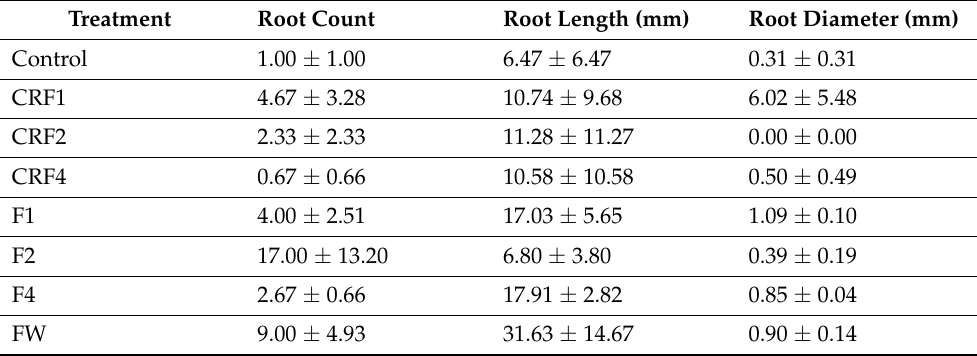
Table 5. Root growth parameters measured in March 2021 at a depth of 15.7–31.4 cm. A one-way analysis of variance (ANOVA) with a Tukey honestly significant difference (HSD) test was used to determine significant differences between means. Data represents means ± standard error.